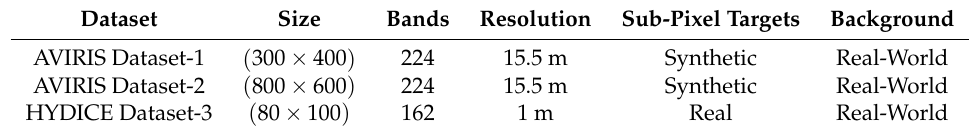
Table 1. Dataset information.